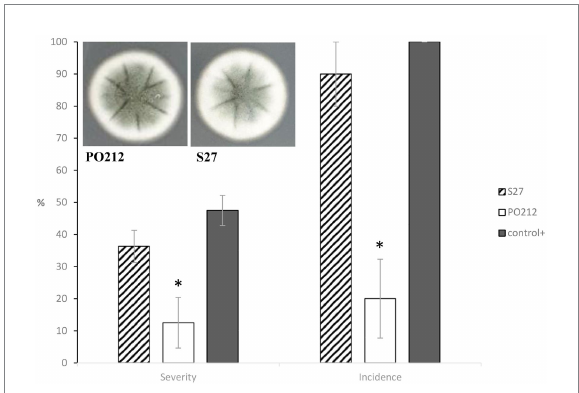
FIGURE 3 Cultures of 7-day-old Penicillium rubens strains 212 and S27 growing on potato dextrose agar (PDA) at 25 ° C (front). The graph shows the effect of PO212- and S27-treatment on percentage of disease severity and incidence caused by Fusarium oxysporum f.sp. lycopersici (FOL) in tomato plants cv. “San Pedro” at 28 days after FOL-inoculation under controlled growth chamber conditions. PO212 and S27 treatments were applied to seedlings 7 days before transplanting by watering with a conidial suspension to a final concentration of 6 × 10 6 conidia g − 1 . Control+, untreated and FOL-inoculated plants. Data are the mean value of five replicates (flasks) per treatment and four plants per replicate. Asterisks in each parameter are significantly different from each other ( p < 0.05) according to the Student– Newman–Keuls multiple range test. Vertical bars represent the standard error of the mean of five replicates. MSE is the mean squared error of ANOVA. SME 182.292 (Severity) and 416.667